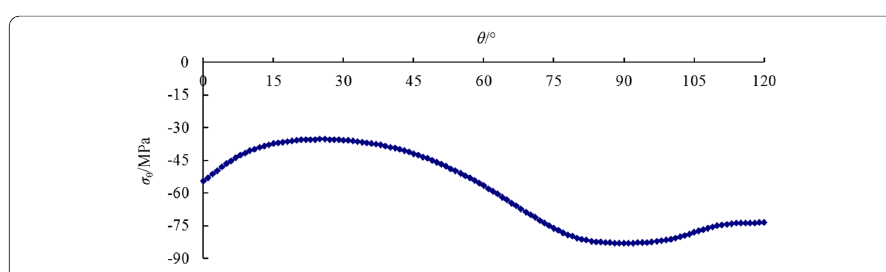
Figure 5 Distribution c of circumferential stress along the middle